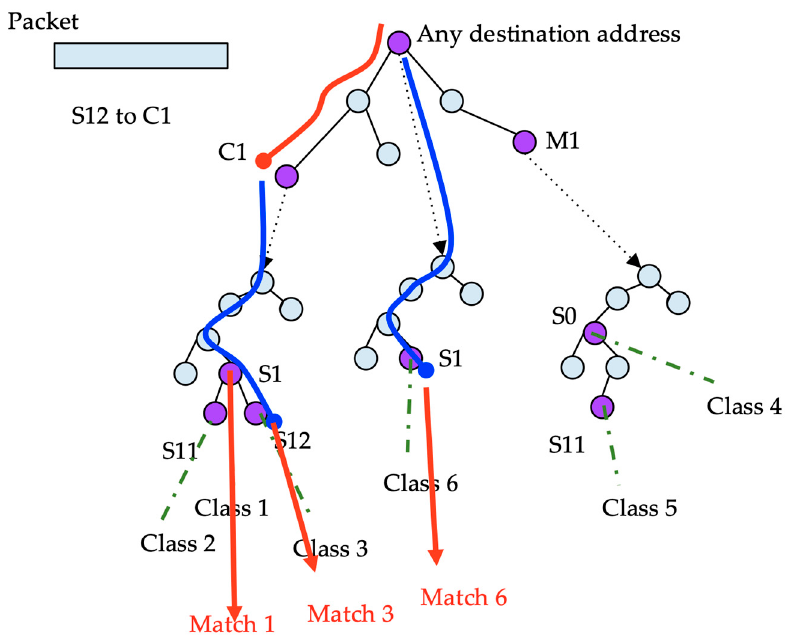
Figure 6. Search procedure example traversing a DStrie. Sensors 2018 , 18 , x FOR PEER REVIEW